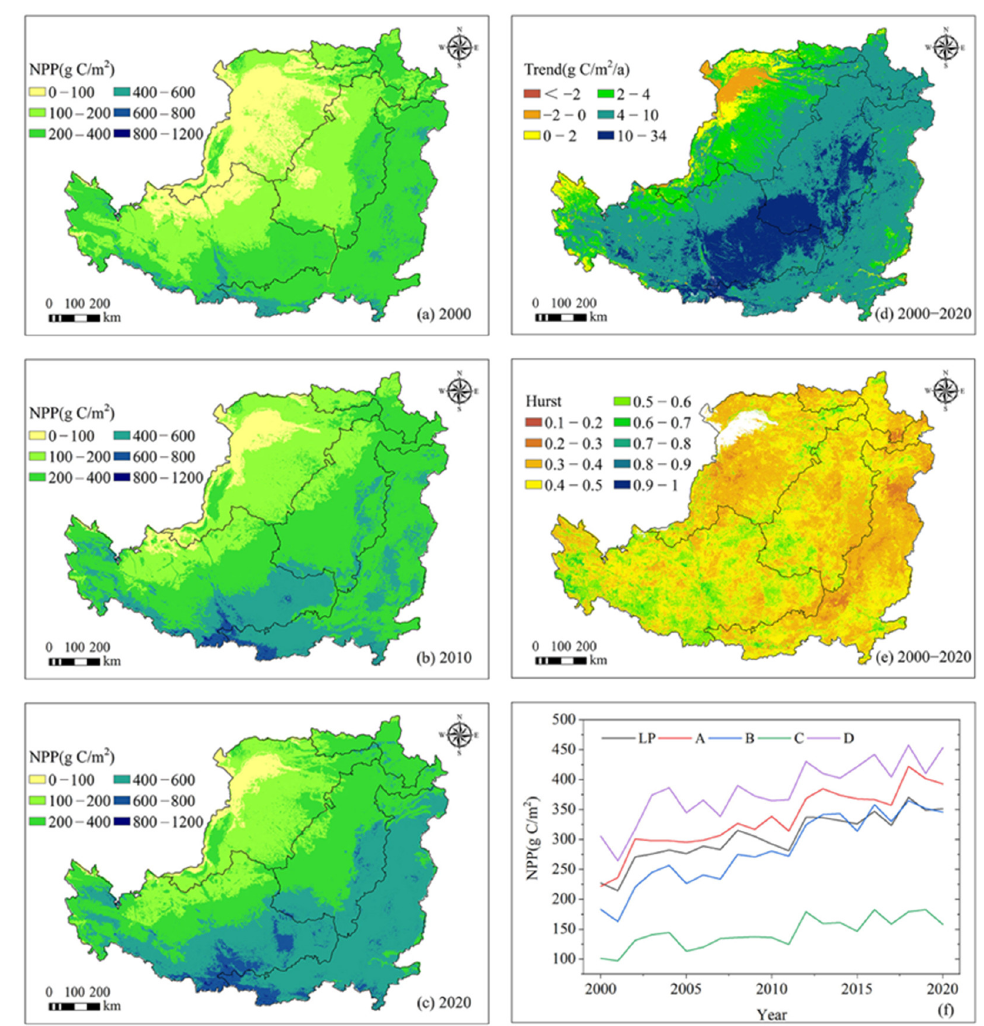
Figure 4. NPP changes in the LP from 2000 to 2020: ( a ) spatial distribution of NPP in 2000; ( b ) spatial distribution of NPP in 2010; ( c ) spatial distribution of NPP in 2020; ( d ) spatial trend of NPP; ( e ) Hurst exponential spatial distribution of NPP; ( f ) interannual variation in NPP.